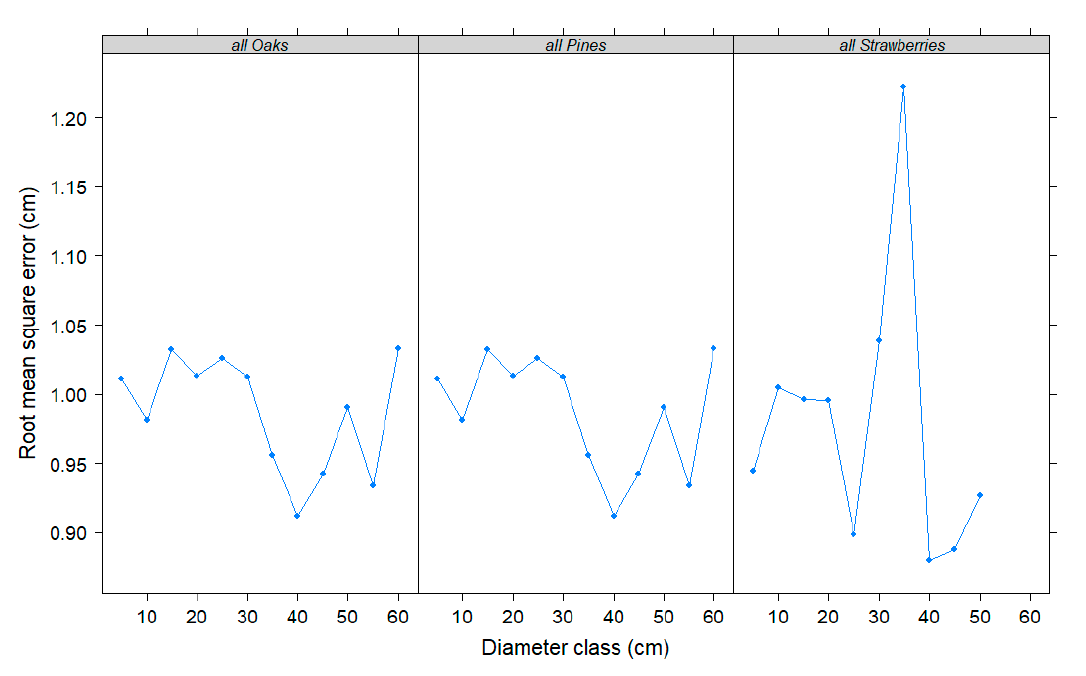
Figure 2. Root mean square error averaged over 5-cm dbh classes for three generic individual diameter growth equations developed in this study.